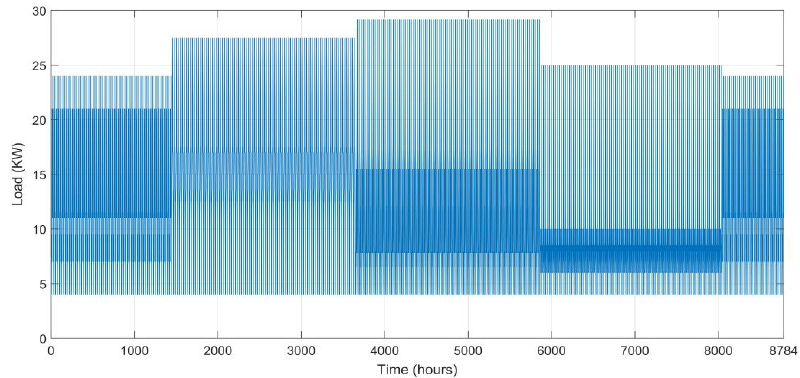
Figure 8. Hourly load profile for the residential units.